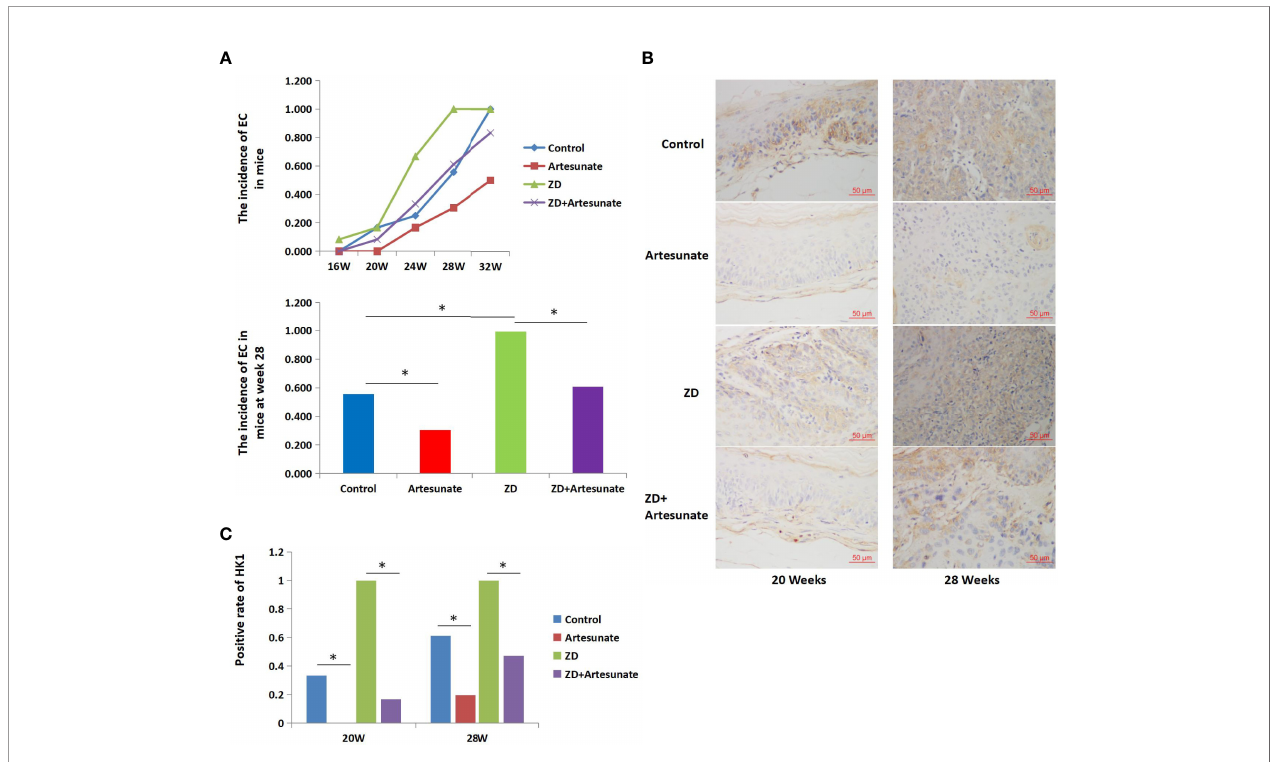
FIGURE 5 | Artesunate decreased the incidence of EC and decreased the expression of HK1 in mice. (A) The incidence of EC in mice at several weeks after 4NQO treatment. (B) Immunohistochemical analysis of HK1 in the esophageal tissues of mice at weeks 20 and 28 after 4NQO treatment. (C) HK1-positive rate in the esophageal tissues of mice at weeks 20 and 28 after 4NQO treatment.*P <